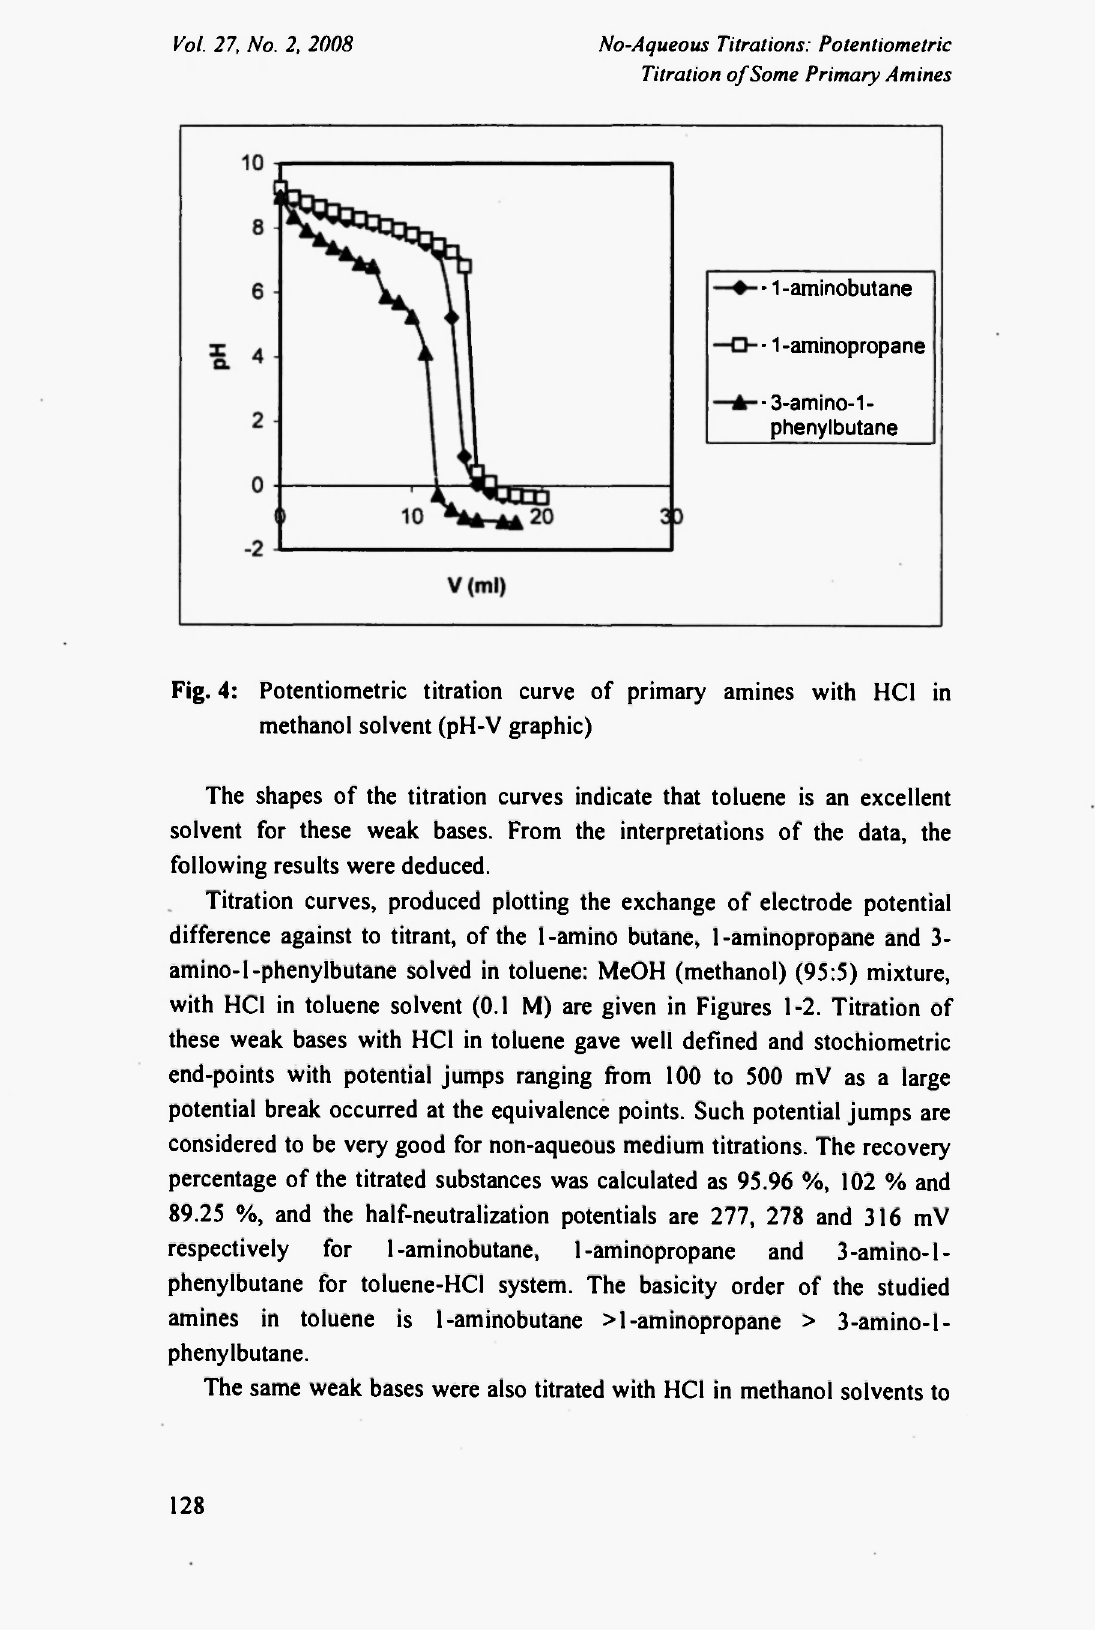
Fig. 4: Potentiometrie titration curve of primary amines with HCl in methanol solvent (pH-V